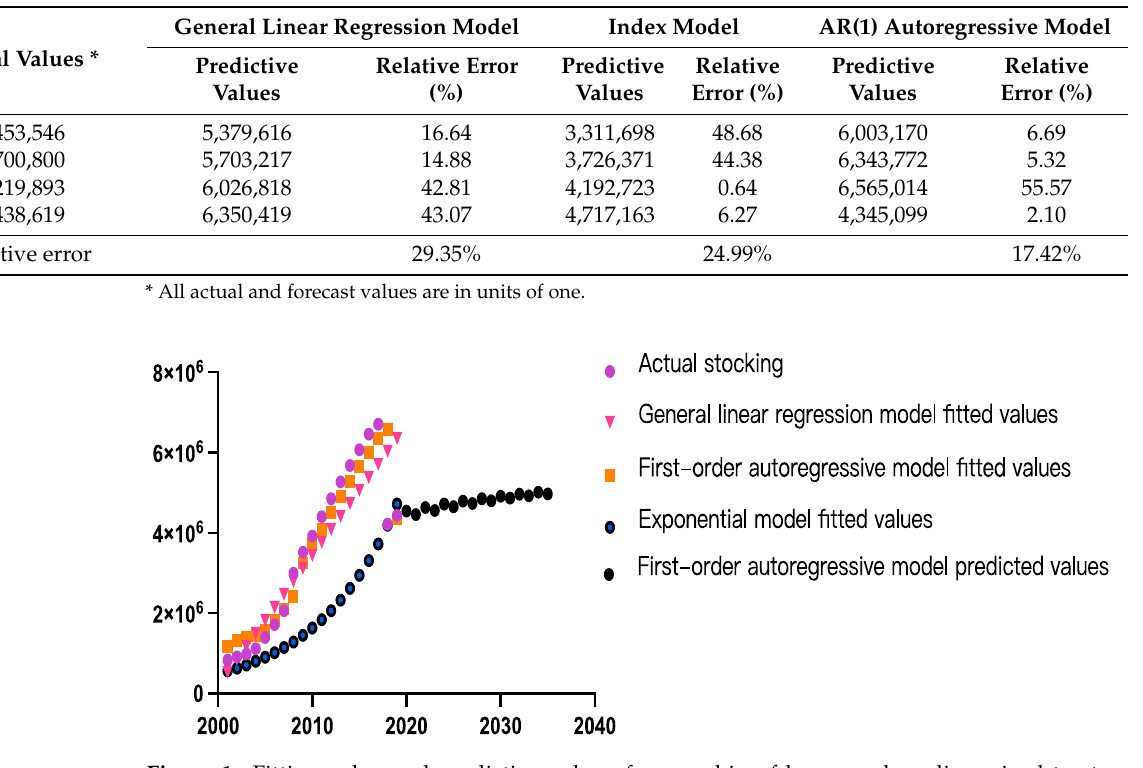
Figure 1. Fitting value and predictive value of ownership of large- and medium-sized tractors in